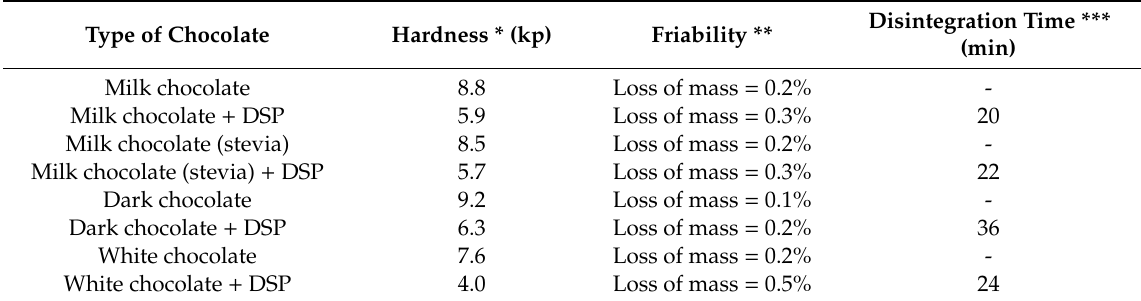
Table 3. Quality control tests—physicochemical properties.